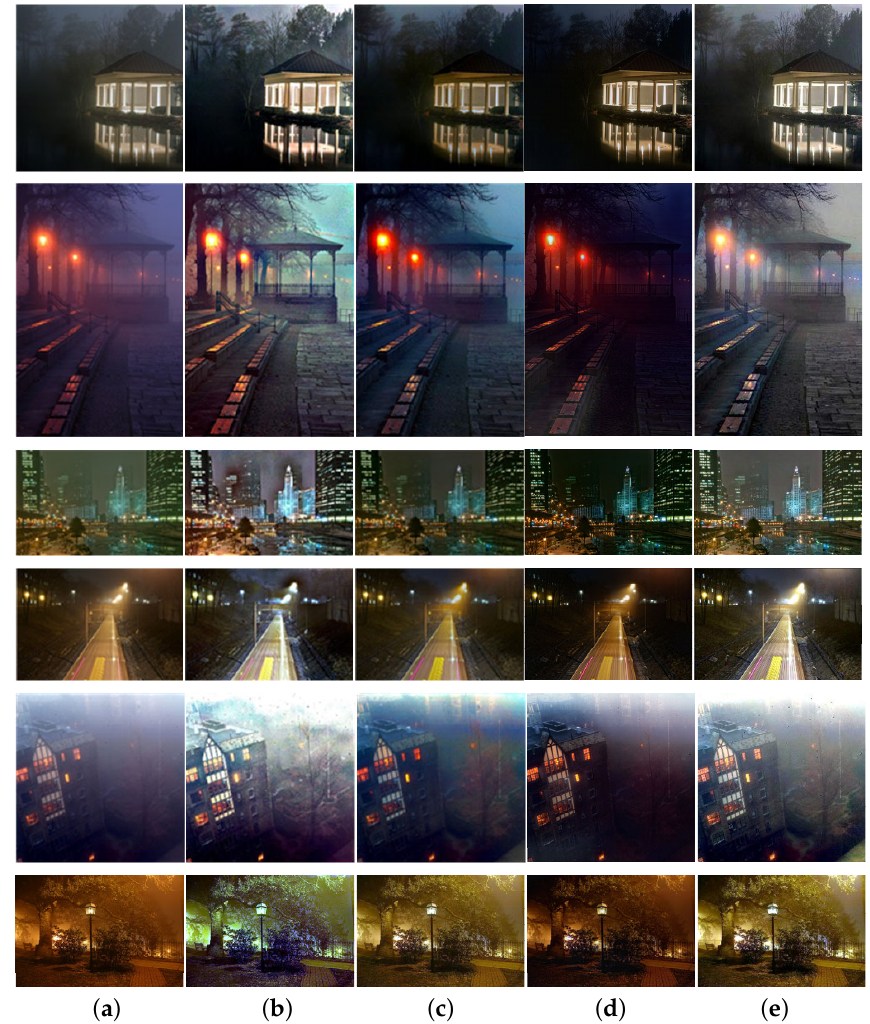
Figure 7. The comparisons of real images. From left to right: ( a ) hazy images, ( b ) results of Li et al. [15], ( c ) results of Zhang et al. [18], ( d ) results of Qu et al. [22], and ( e ) results of